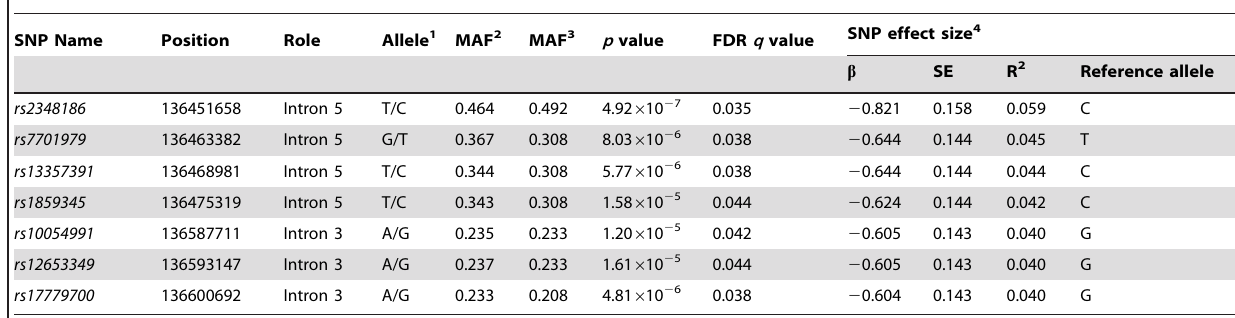
Table 2. SNPs identified in GWAS with genome-wide significant FDR q